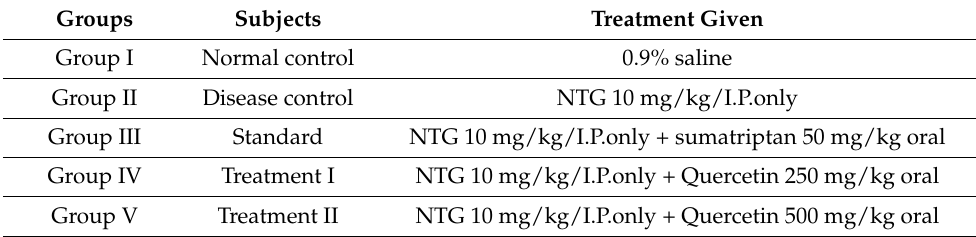
Table 1. Grouping of animals.